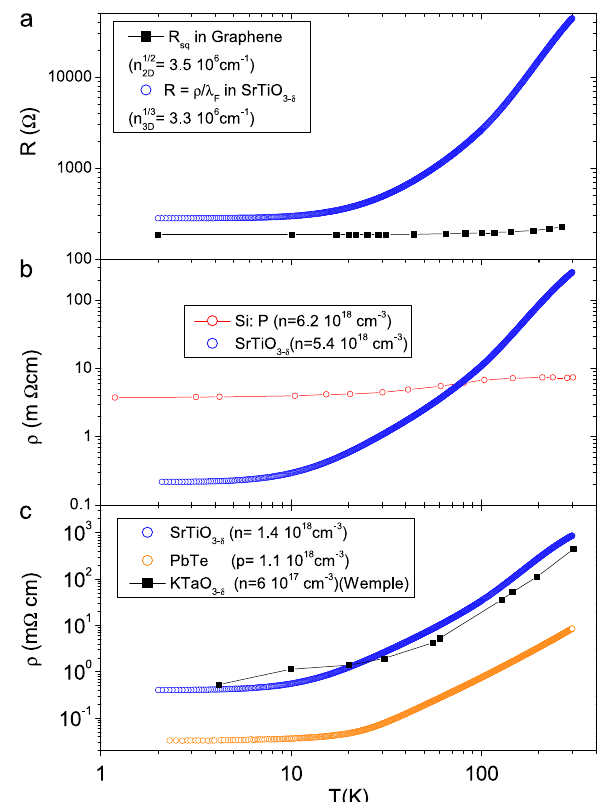
Fig. 3 Comparison with other dilute metallic systems. a R □ of a one Fermi-wavelength-thick sheet of SrTiO 3 − δ compared with gra- phene 40 with comparable areal carrier density. b Temperature- dependence of resistivity in SrTiO 3 − δ and in metallic silicon 41 with comparable volume carrier concentration. c Temperature- dependence of resistivity in SrTiO 3 − δ , metallic PbTe and metallic KTaO 3 − δ 42 in similar range of carrier concentration. In silicon and graphene, the change in resistance caused by phonon scattering of electrons is a modest part of the total resistance. In all other systems, which are close to a ferroelectric instability, resistivity changes by several orders of Fig. 3a, which compares the temperature-dependence of resistiv- ity in n-doped SrTiO 3 and graphene at an identical inter-electron distance. As one can see in the fi gure, resistivity changes by 200 in SrTiO 3 and by 1.6 in graphene. Charge conductivity is higher in graphene by a factor of two at low temperature and by two orders of magnitude at room temperature. A comparison with the case of metallic silicon 41 reveals a similar discrepancy. As one can see in Fig. 3b, cooling phosphorous-doped silicon leads to a modest change in resistivity, much less than what is seen in doped SrTiO 3 . As a consequence, while at low-temperature, strontium titanate has a signi fi cantly higher mobility, the opposite is true at room temperature. In contrast to strontium titanate, in both graphene and silicon, one can use Eq. (1) one to extract a meaningful mean- free-path, which increases by a factor of two or less as the system is cooled down from room temperature to helium liquefaction temperature. It is also instructive to compare SrTiO 3 with two other dilute metals close to a ferroelectric instability. As one can see in Fig. 3c, both PbTe and KTaO 3 show comparably large changes in their resistivity upon cooling. Reports on KTaO 3 , 19, 42 and on lead chalcogenide salts (PbTe, PbSe and PbS) 43, 44 indicate that high- temperature mobility does not vary with carrier concentration, but shows a strong temperature dependence ( μ ∝ T − λ , with λ ’ 2 : 5 (cid:4) 3). Both these features are similar to what we see in